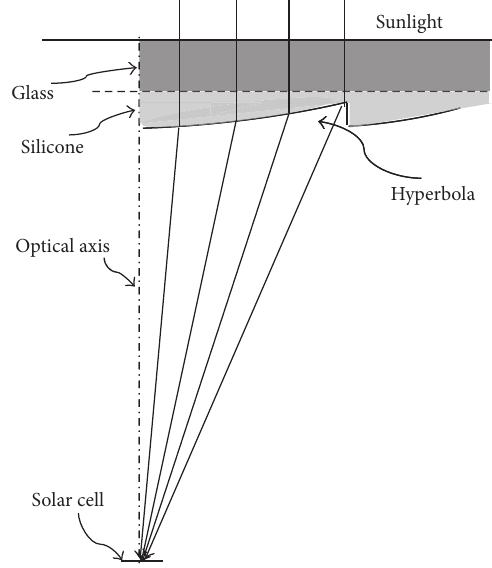
Figure1:Determination oftheprofileforeach groovewiththemain wavelength 𝜆 . Only one center groove of Fresnel lens is drawn for interpreting.